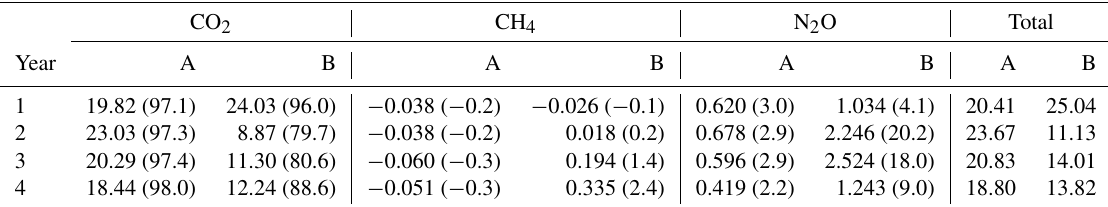
Table 4. Annual soil GHG fluxes expressed as CO 2 equivalents (tCO 2 e ha − 1 yr − 1 ) using the IPCC global warming potential value for each gas in area A (mature spruce stand, remaining) and area B (mature spruce stand, clear-felled after year 1) in Harwood Forest. Values in brackets are the % contribution to total CO 2